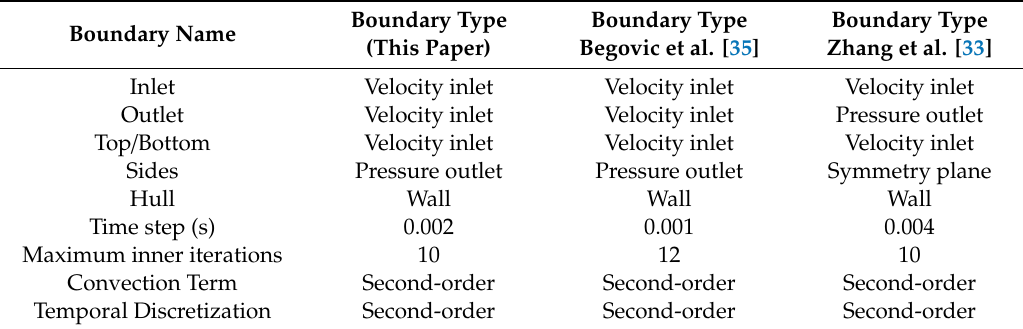
Table 4. Boundary conditions and solver